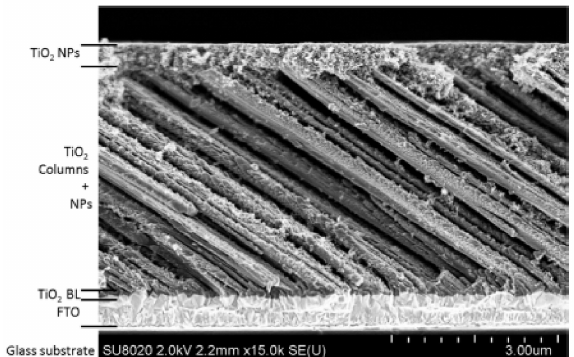
Figure 20. Cross-sectional SEM picture of a slanted columnar thin film (4.3 µ m) after spin coating by a TiO 2 nanoparticles